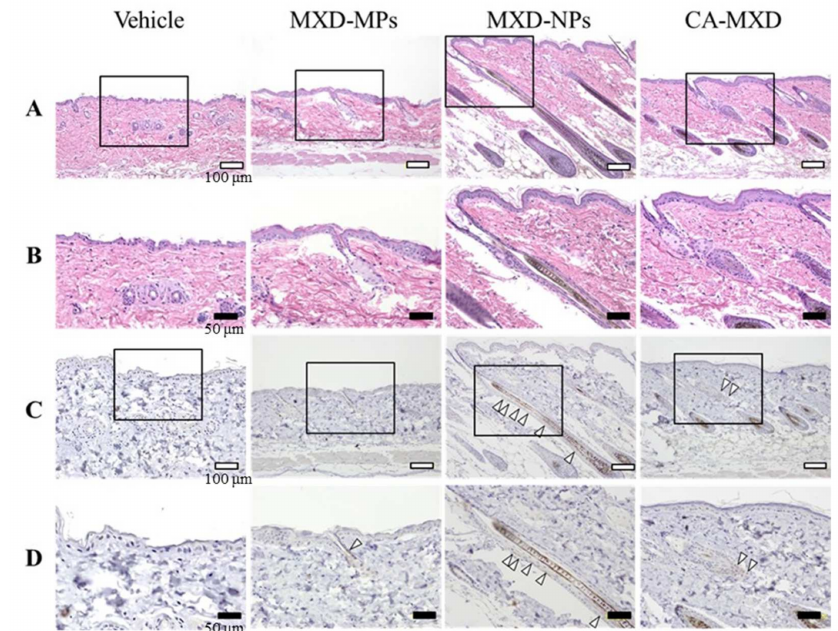
Figure 7. Microscopic effects of MXD formulations on skin tissue (hair bulge and hair bulb) of C57BL/6 mice at 8 d after the start of repetitive applications (once a day). ( A ) Images of H&E-stained skin tissue specimens from C57BL/6 mice (bars indicate 100 µ m). ( B ) High magnification microscope images in the areas designated by the squares in Figure A (bars indicate 50 µ m). ( C ) Optical images of immunostaining for CD200 in the serial segments shown in Figure A (bars indicate 100 µ m). ( D ) High magnification microscope images of the areas designated by the squares in Figure C (bars indicate 50 µ m). Vehicle, only the vehicle used to prepare the MXD-MPs and MXD-NPs formulations was applied. MXD-MPs, MXD-MPs-applied mice. MXD-NPs, MXD-NPs-applied mice. CA-MXD, CA-MXD-applied mice. The arrow shows the expression of CD200. CD200 is stained brown; the expression of CD200 was enhanced in the MXD-NPs group, compared with the CA-MXD